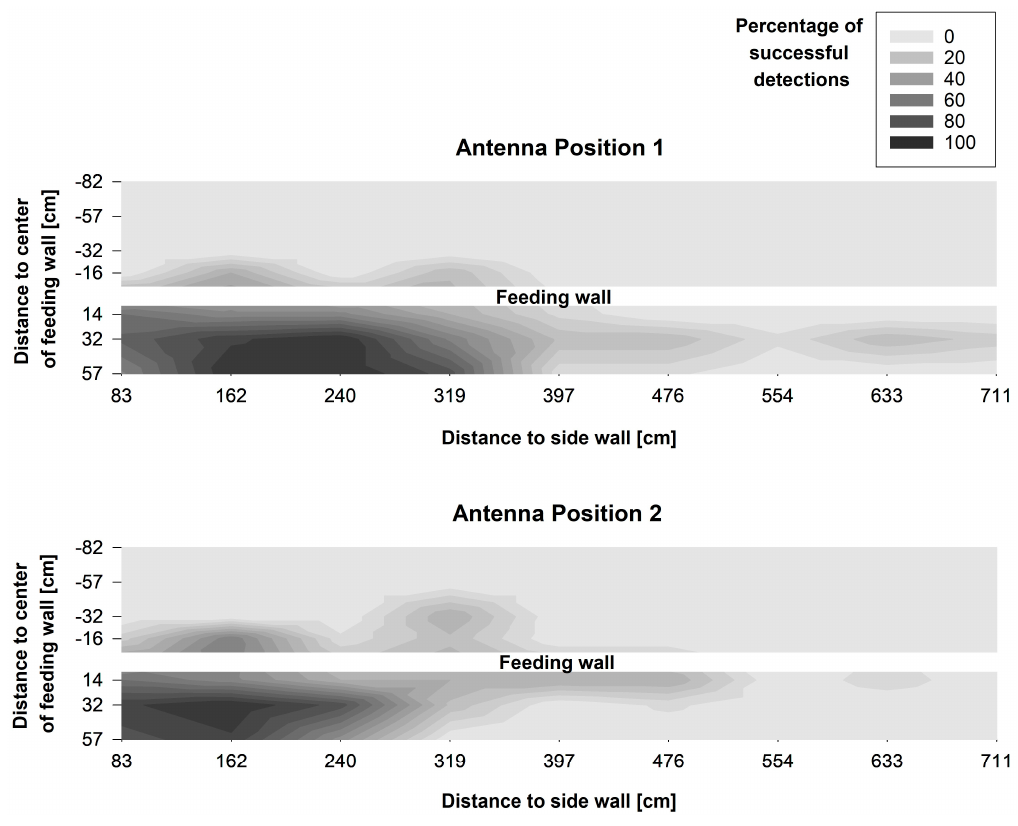
Figure 6. Interpolated contour plot showing the percentage of successful detections per coordinate of UHF ear tag Type A overall heights and for both antenna positions. Major ticks on the x- and y-axes indicate the measurement coordinates. Each x-coordinate represents the centre of a feeding place along the feed fence.